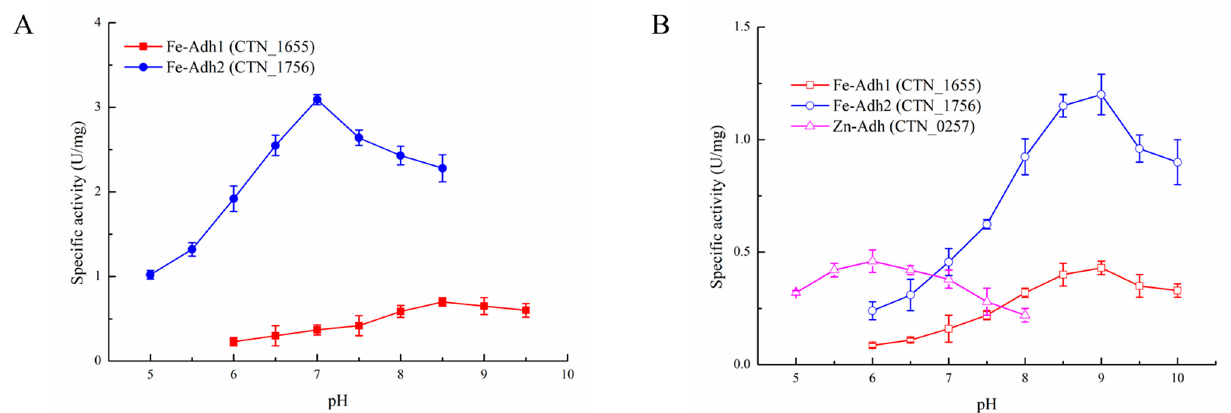
Figure 2. The effects of pH on the enzymatic activity of the three Adhs from T. neapolitana : ( A ) forward reaction for Fe-Adh1 and Fe Adh2; ( B ) reverse reaction for Fe-Adh1, Fe-Adh2, and Zn-Adh. All of the enzymatic activity was determined at the optimal temperature. All of the activity assays were performed in triplicate, and data reported here are the mean of the three replicates.